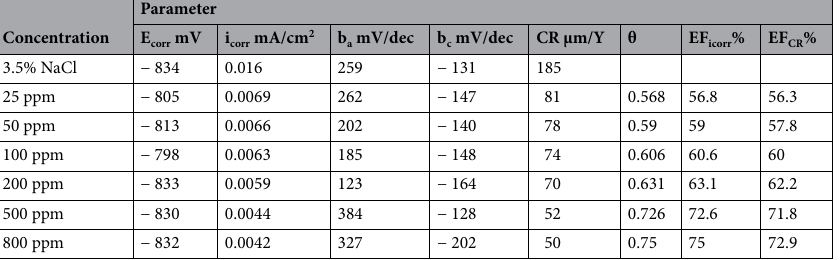
Table 1. Polarization parameters obtained for carbon steel in 3.5% NaCl-free and containing [BMIm]TfO.